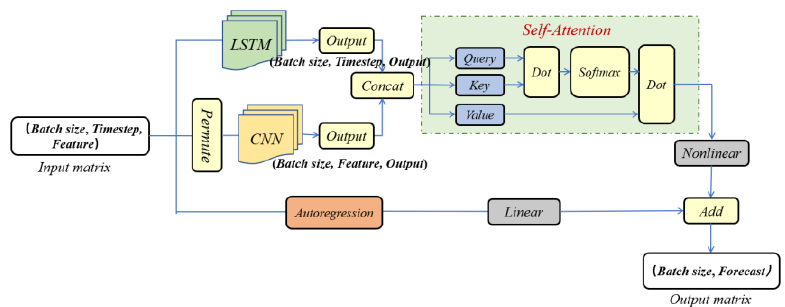
Figure 3. Flowchart of SA-CNN-LSTM model.